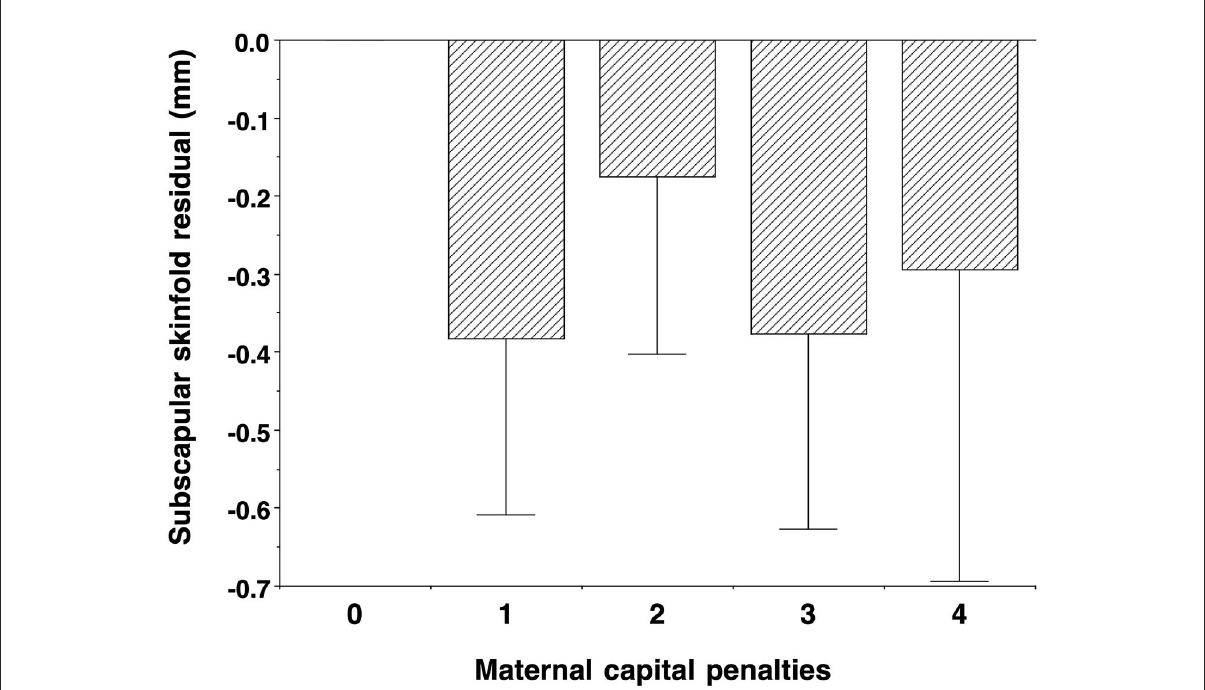
FIGURE6 Dose-response associations of subscapular skinfold, adjusted for triceps skinfold, according to the number of “penalties” in maternal capital, relative to 0 penalties as the reference group. Lower maternal capital was not associated with a more central fat distribution. Test for trend p =